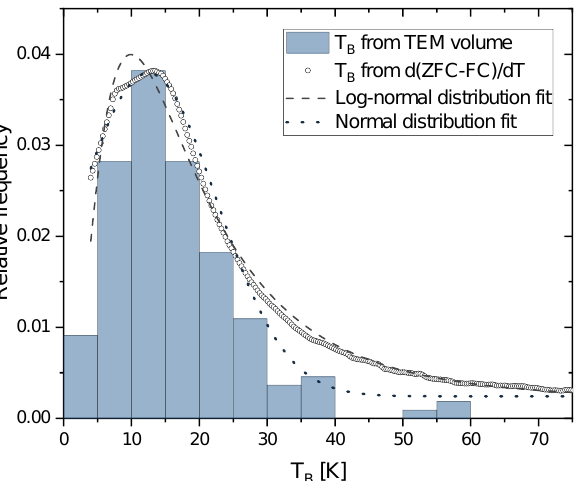
Figure 9. Blocking temperature distribution obtained by Equation (12) with log-normal fit ( (cid:104) T B (cid:105) = 20.8K) and normal distribution fit ( (cid:104) T B (cid:105) = 12.8K) together with calculated blocking tempera- ture distribution based on Equation (7) obtained from the TEM size distribution and K = 21.2kJ/m 3